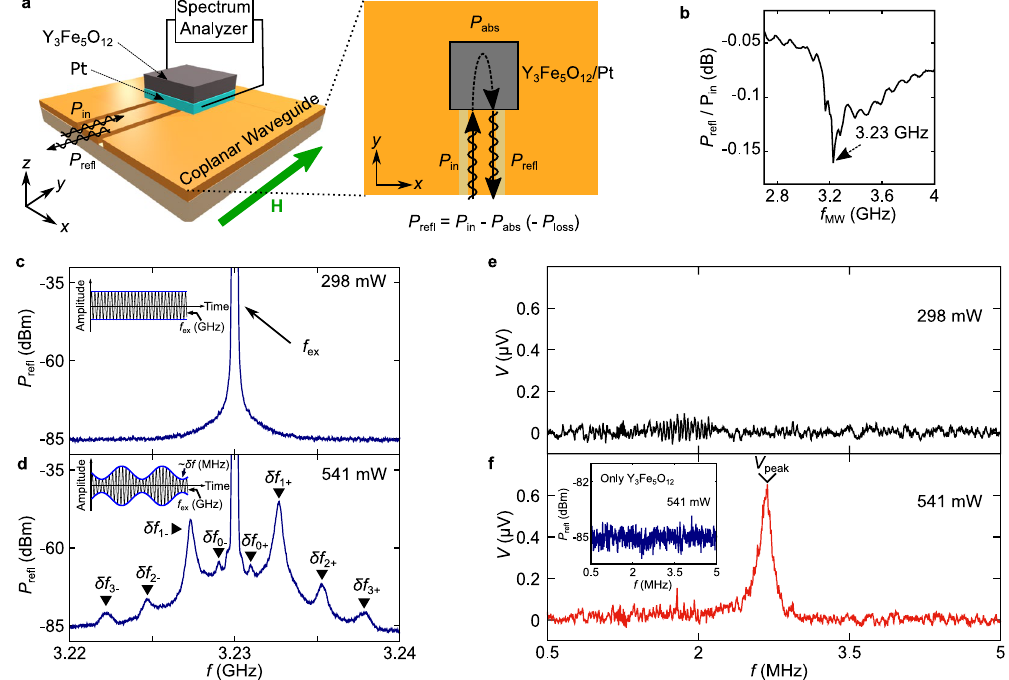
Figure 2. Generation of MHz-band voltages from GHz-band microwaves. ( a ) Schematic illustration of the experimental set-up for the ferromagnetic resonance (FMR) and spin pumping measurements. H denotes the static magnetic field; P in the power of the incident microwave; P refl the reflected microwave; P abs the absorbed microwave by spin-wave resonance in Y 3 Fe 5 O 12 ; P loss the return loss on the equipment. ( b ) Microwave frequency, f MW , dependence of the microwave absorption P refl /P in . The P in and the magnitude of H ( H ) were set at 541 mW and 545 Oe, respectively. ( c , d ) Microwave-power dependence of the reflected microwave at P in = 298 mW ( c ) and 541 mW ( d ). The most prominent excitation frequency ( f ex ) is 3.23 GHz. H was set at 545 Oe. In 541 mW, δ f 0 ± , δ f 1 ± , δ f 2 ± and δ f 3 ± are the sidepeak frequencies of reflected microwaves by the AO. The δ f 1 is the fundamental frequency of the AO. δ f 2 and δ f 3 are higher harmonic components of δ f 1 . δ f 0 is a subharmonic component of δ f 1 . The insets to ( c ) and ( d ) show schematic illustrations of the waveforms of the output microwave at P in = 298 mW ( c , AO is off) and 541 mW ( d , AO is on). P refl becomes the amplitude- modulated wave by the AO. ( e,f ) Voltage, V , spectra for the Pt/Y 3 Fe 5 O 12 film at P in = 298 mW ( e ) and 541 mW ( f ). The frequency of the voltage is approximately 2.7 MHz. The inset to ( f ) shows the frequency spectrum of P refl at P in = 541